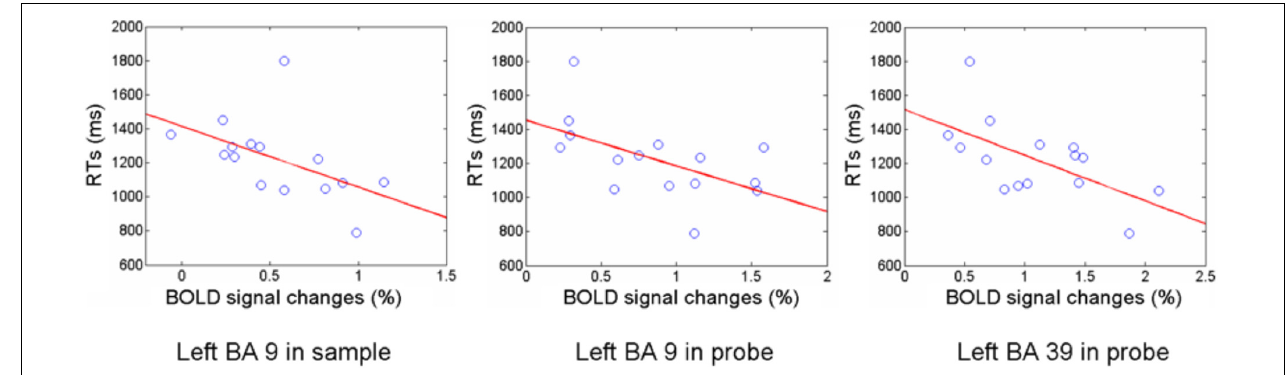
FIGURE 5 | RT and activation amplitude correlations. Correlation between reaction time and brain activation in BA9 in the sample phase of the integrate task, and in BA 9 and BA 39 during the probe phase of the integrate